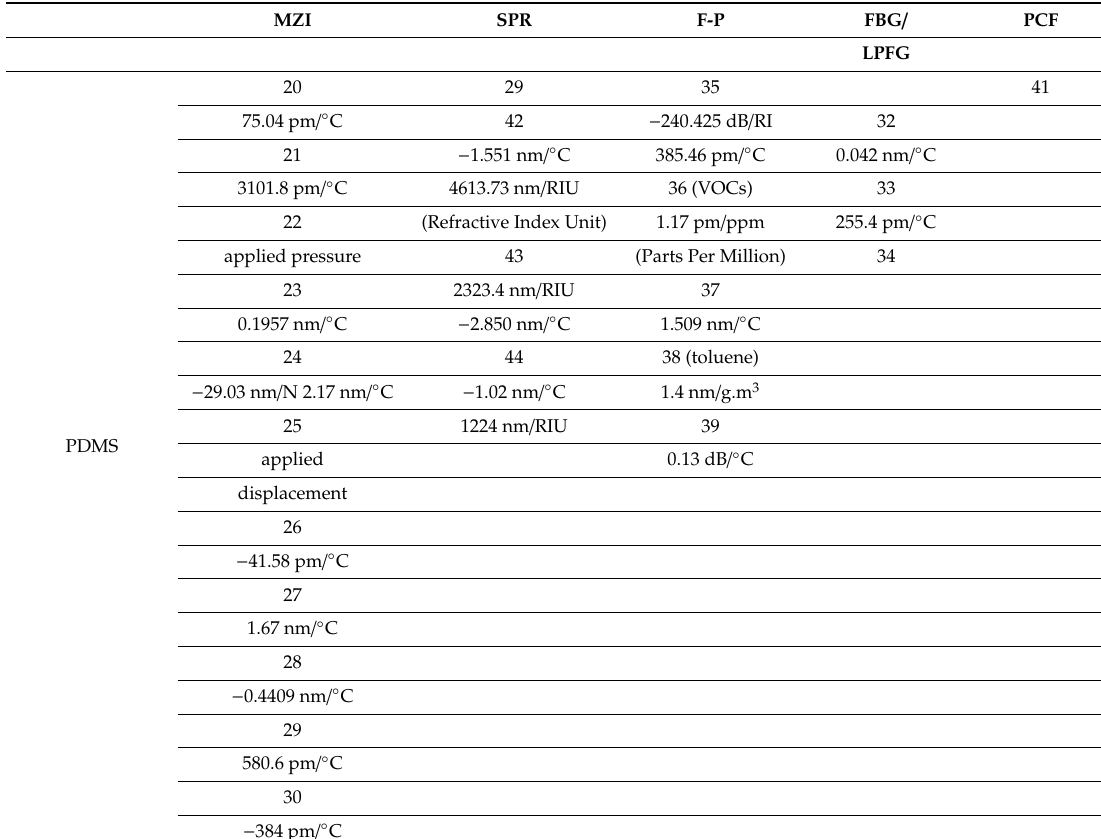
Table 2. A conclusion of the sensing function and sensitivities.